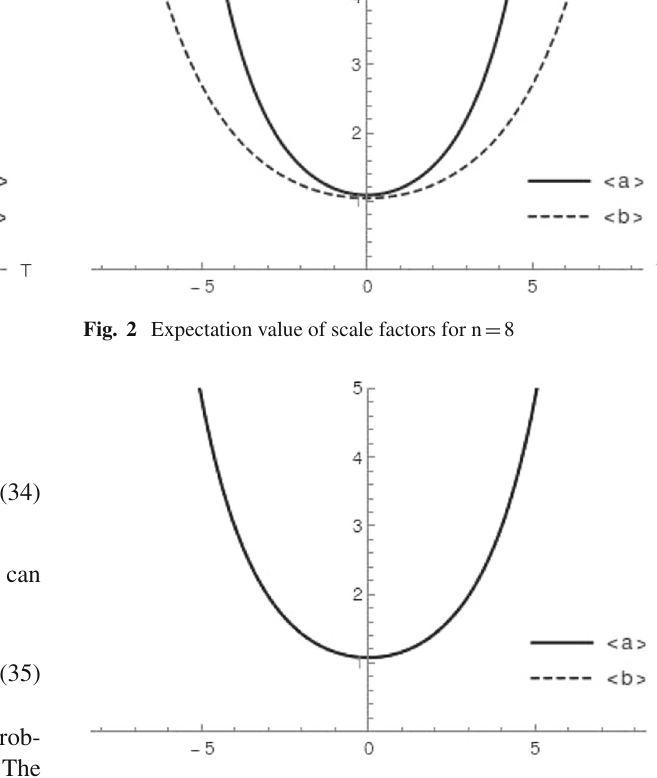
Fig. 3 Expectation value of scale factors for n = 7 is given above and as it is shown, they both coincide